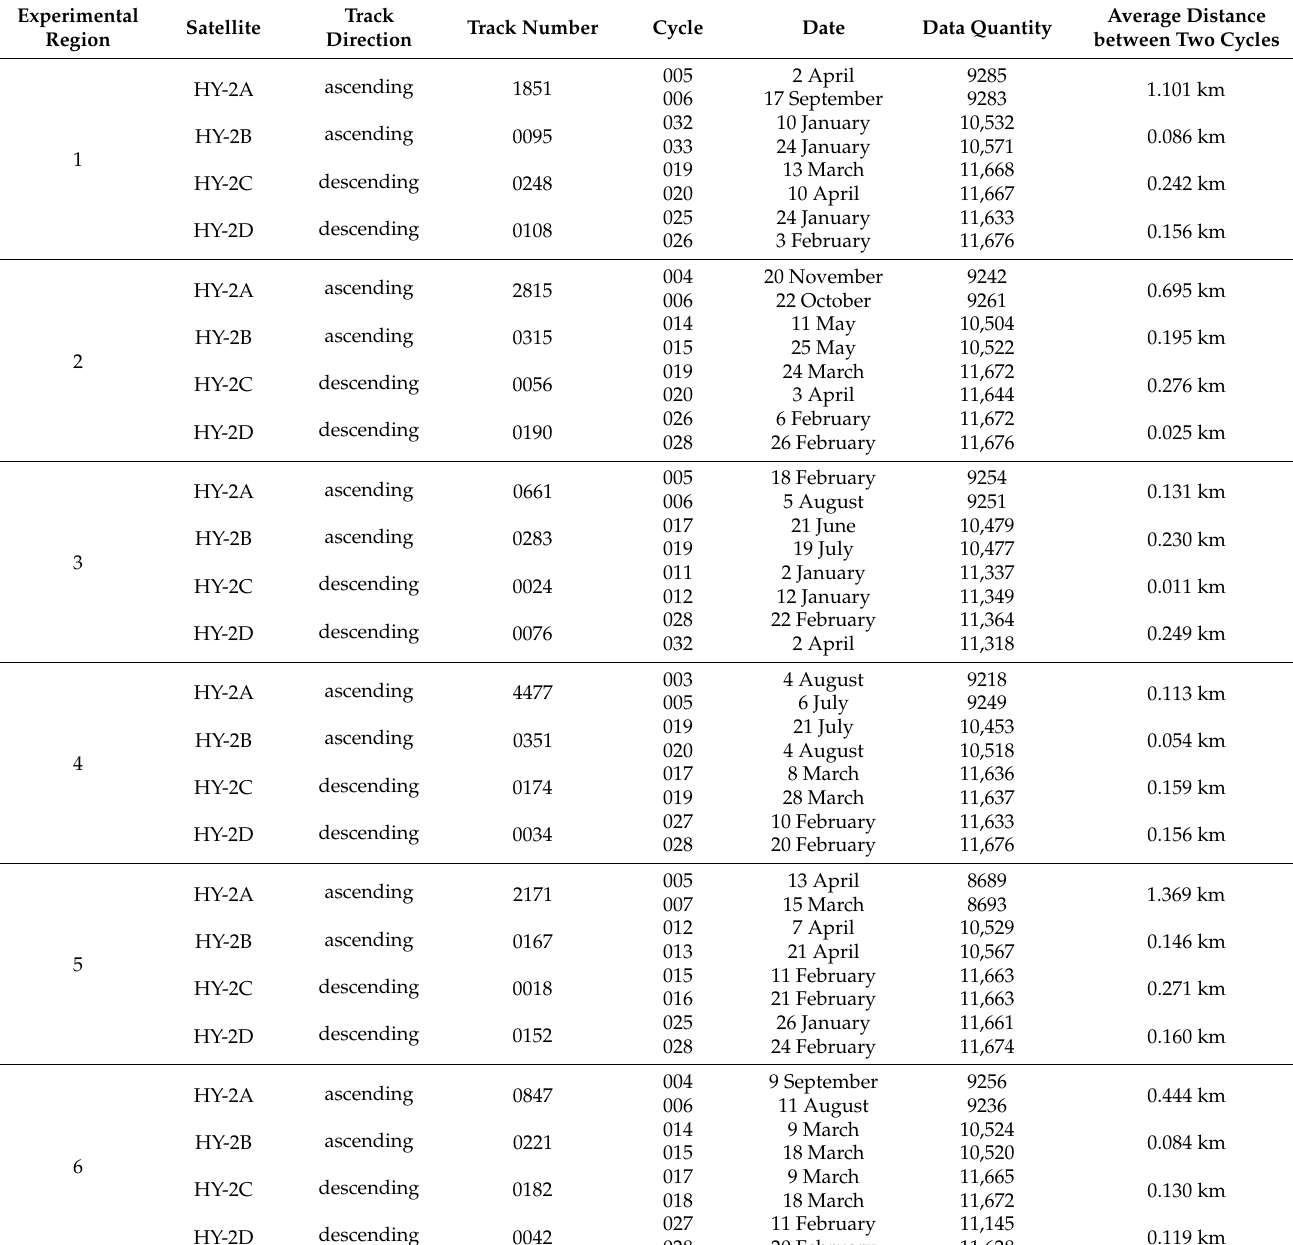
Table 3. Summary of information for sample data sequences in 6 research regions: Region 1, North Pacific; Region 2, South Pacific; Region 3, Mid-Pacific; Region 4, Indian Ocean; Region 5, North Atlantic; Region 6, South Atlantic.